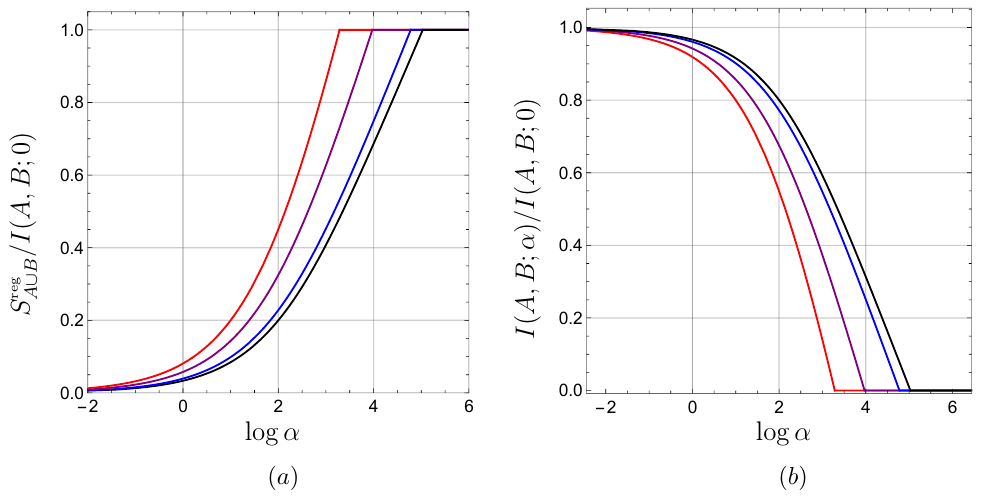
Figure 6 . (a) Regularized entanglement entropy S reg function of log (cid:11) . Both in (a) and (b) the curves correspond to a = 0 (black curves), a = 0 : 8 (blue curves), a = 1 : 2 (purple curves) and a = 1 : 5 (red curves). In all cases we have (cid:12)xed r